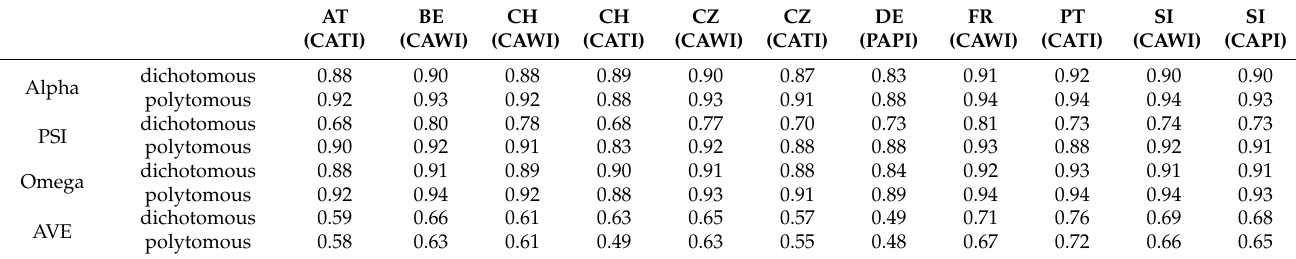
Table 7. Cronbach’s alpha, Person Separation Index (PSI), omega, and average variance ex- tracted (AVE) for the HLS 19 -NAV based on dichotomous and polytomous data (partly taken from